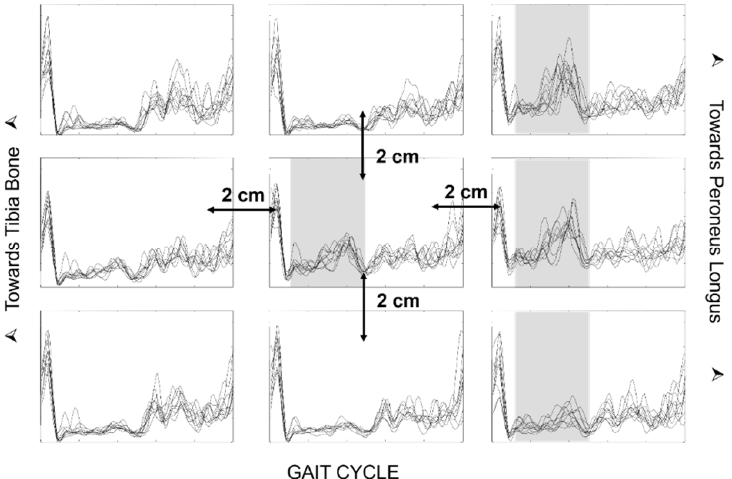
Figure 25. Envelopes of bipolar sEMG (one plot per stride for 10 strides) from nine electrode pairs obtained by placing a 4 × 3 grid of electrodes, 15 × 18 mm in size, over the anterior aspect of the leg. The medial column of electrodes is placed on the edge between the tibialis anterior muscle and the tibia bone. The gray bands indicate the presence of activity in the mid and terminal stances due to signals coming from the peroneus longus. Adapted with permission from Ref. [66]. Copyright Journ. of Electromyography and kinesiology, 2007.